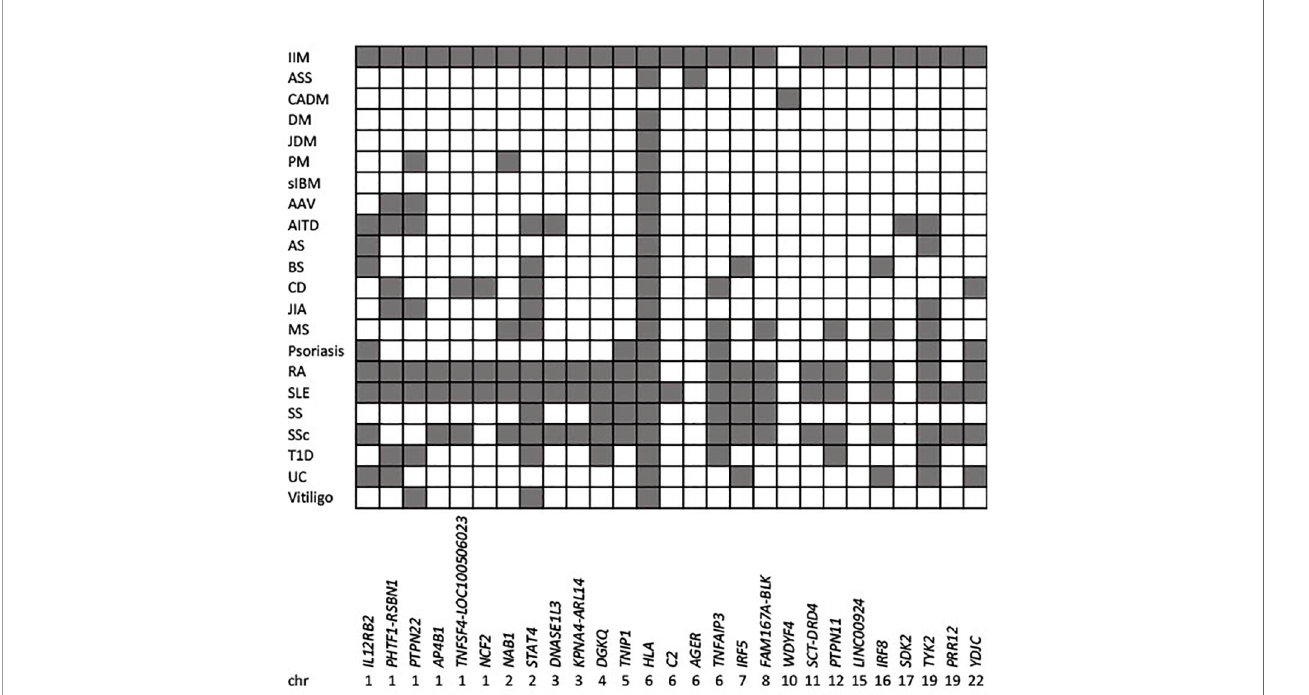
FIGURE 1 | Genetic overlap between idiopathic in fl ammatory myopathies and other autoimmune diseases. IIM associated loci meeting genome-wide signi fi cance (p<5x10 -8 ) for IIM as a whole, or for different clinical subgroups are indicated by the reported gene/s, and ordered by chromosomal location (x axis). Shaded squares showlociassociatedwithIIM,andother autoimmunetraits(yaxis) reportedintheGWAScataloguev1.0.2(www.ebi.ac.uk/gwas/home; ExperimentalFactorOntology “ Immune system disorder ” ). AAV, Anti-neutrophil cytoplasmic autoantibody (ANCA)-associated vasculitis; AITD, autoimmune thyroid disease; AS, ankylosing spondylitis; ASS, anti-synthetase syndrome; BS, Behcet ’ s syndrome; CADM, clinically amyopathic dermatomyositis; CD, celiac disease; DM, dermatomyositis; IIM, idiopathic in fl ammatory myopathies; JDM, juvenile dermatomyositis; JIA, juvenile idiopathic arthritis; MS, multiple sclerosis; PM, polymyositis; RA, rheumatoid arthritis; sIBM, sporadic inclusion body myositis; SLE, systemic lupus erythematosus; SS, Sjogren ’ s syndrome; SSc, systemic sclerosis; UC, ulcerative